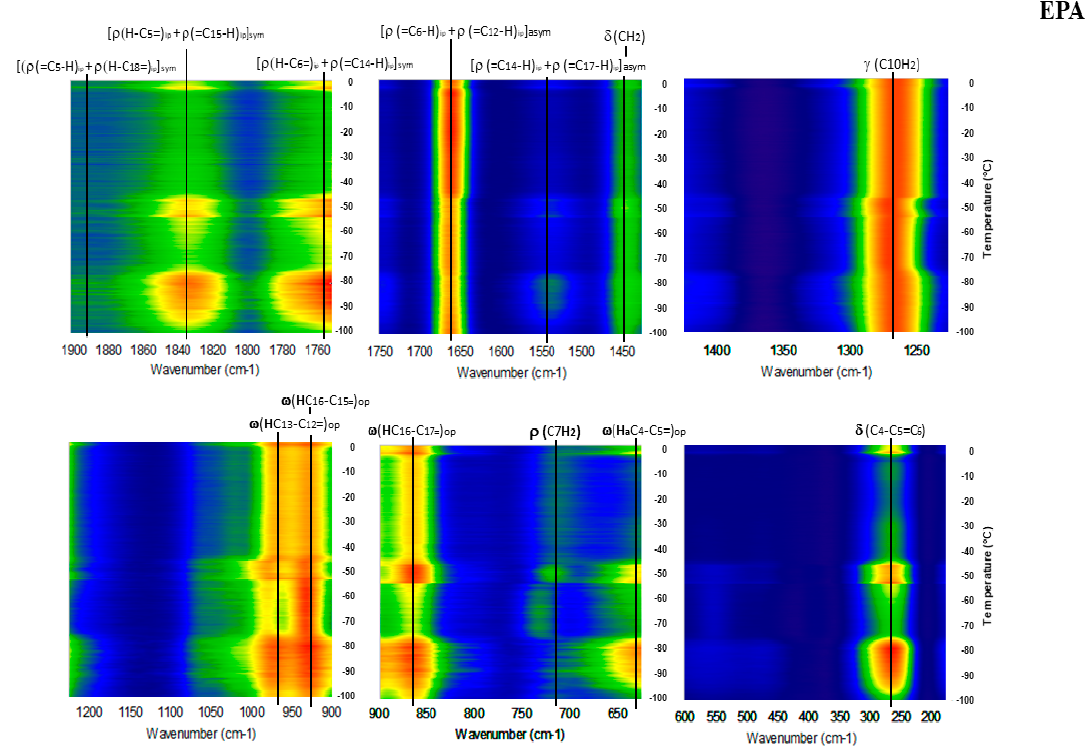
Figure 2. EPA gradient temperature Raman spectroscopy (GTRS) contour plot with vibrational mode assignments. Intensity normalized to 1650 cm − 1 . Note, major Raman mode discontinuities and frequency shifts that correlate with the large changes in heat flow shown in Figure 1.